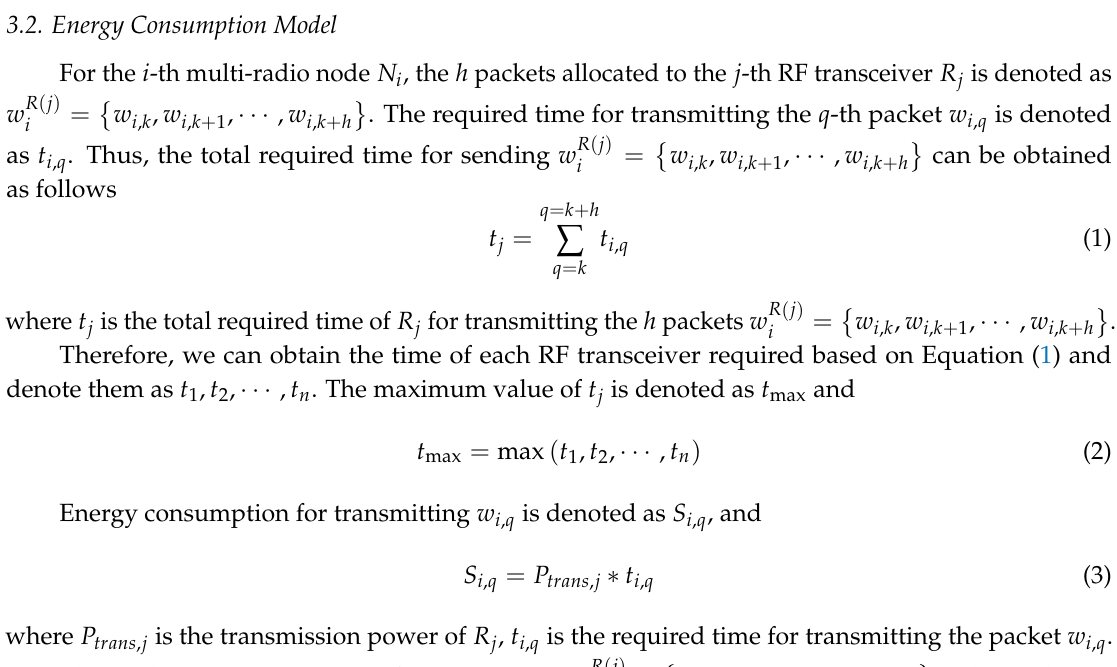
Figure 1. Task scheduling